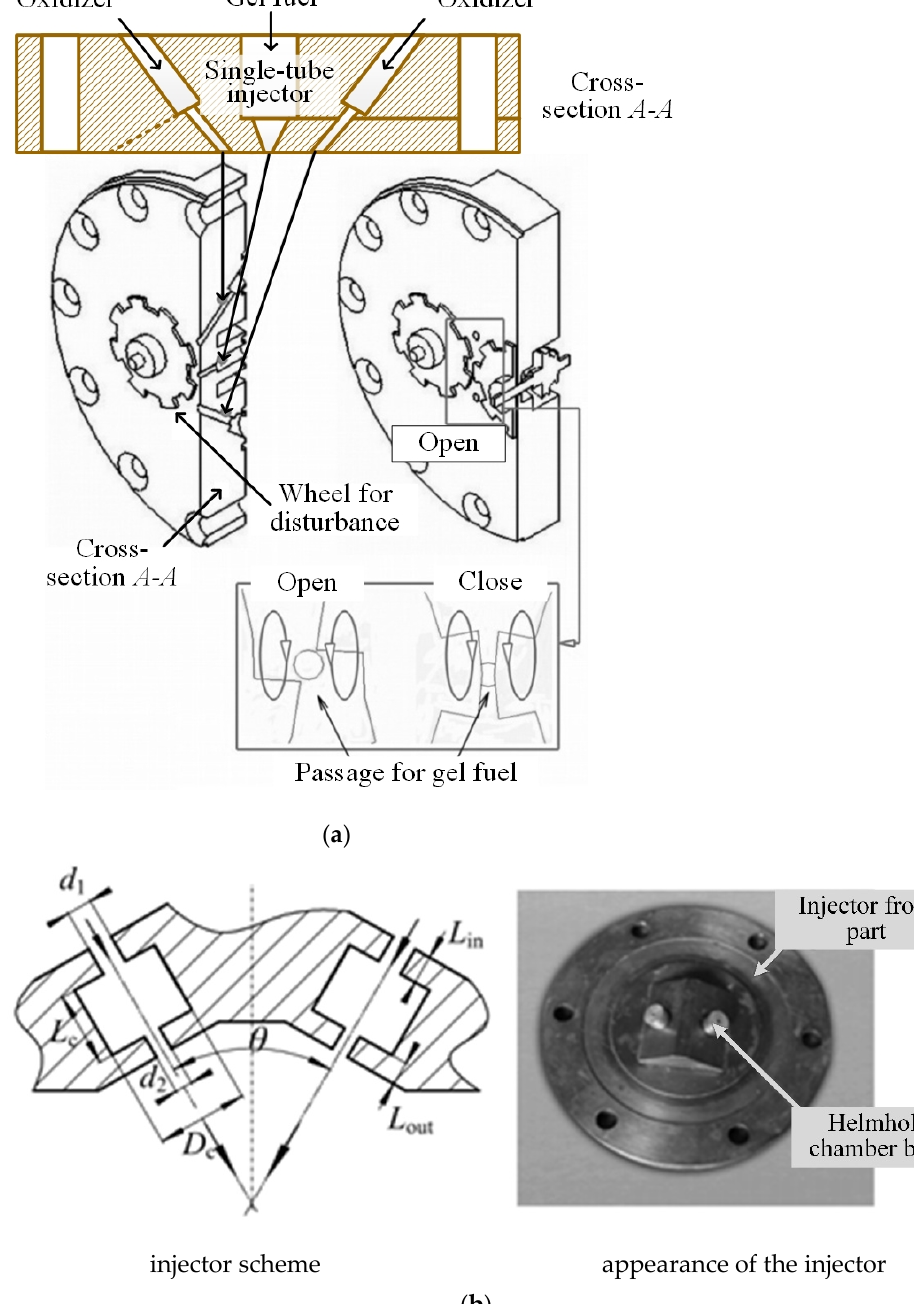
Figure 11. Schematic representation of an improved three-jet spray atomization ( a ) and a two-jet spray atomization with a Helmholtz chamber ( b )